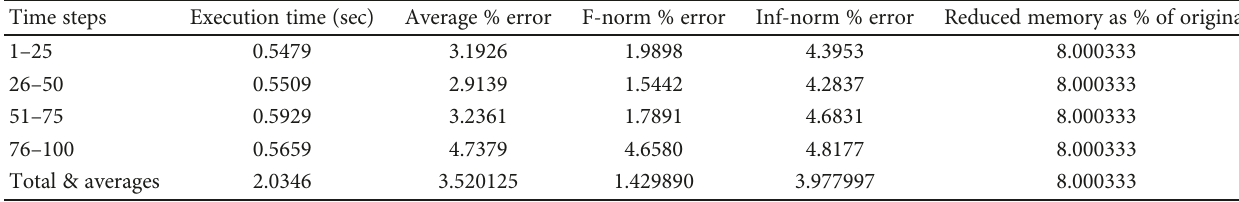
Table 18: 3D reduced model of stagnation energy over four sets of 25 time steps.